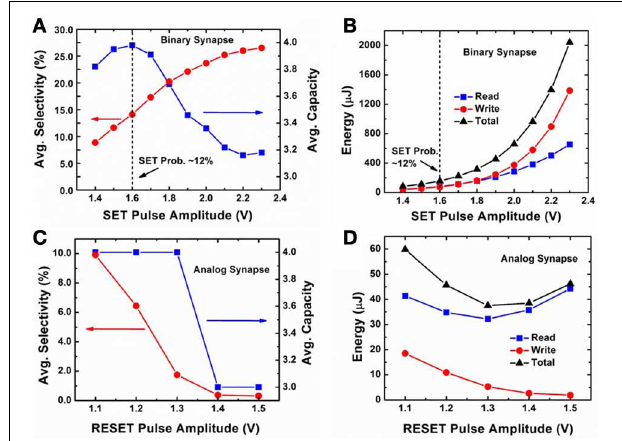
FIGURE 6 | Simulated system performance metrics as a function of programming conditions. Network orientation selectivity and orientation storage capacity for binary synapse in (A) and for analog synapse in (C) ; Energy consumption of the synaptic devices during the whole training (200 training images) for binary synapse in (B) and for analog synapse in (D) . The average values through 100 independent simulation runs are shown. + 1.6V/10ns is chosen as the optimized programming condition for binary synapse, which corresponds to a SET success probability ∼ 12% on average. And − 1.1V/10ns is chosen as the optimized programming condition for analog